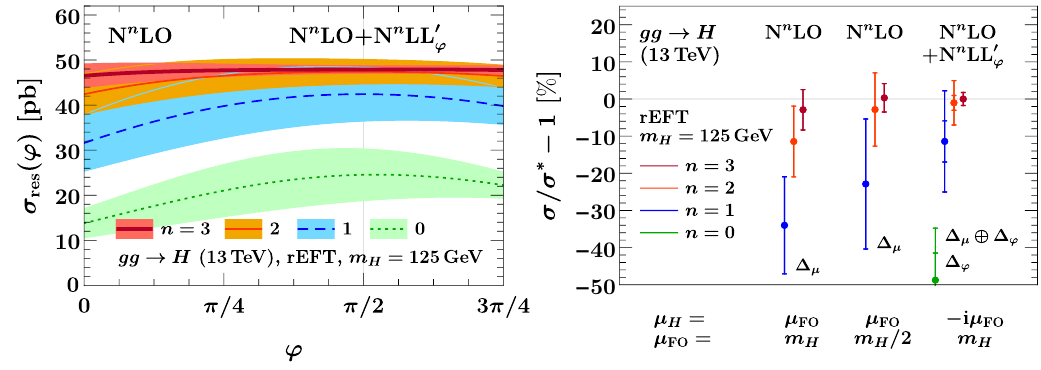
Figure 4 . The gg ! H cross section at E cm = 13 TeV and m H = 125 GeV in the rEFT scheme. Left: the cross section as a function of the resummation phase ’ of the hard scale (cid:22) H = (cid:22) FO exp( (cid:0) i ’ ), with the uncertainty bands corresponding to (cid:1) (cid:22) only. Right: comparison of the (cid:12)xed-order results for (cid:22) FO = m H and (cid:22) FO = m H = 2, and the resummed results with (cid:22) FO = i (cid:22) H = m H . All results are given as the percent di(cid:11)erence from the N 3 LO+N 3 LL 0